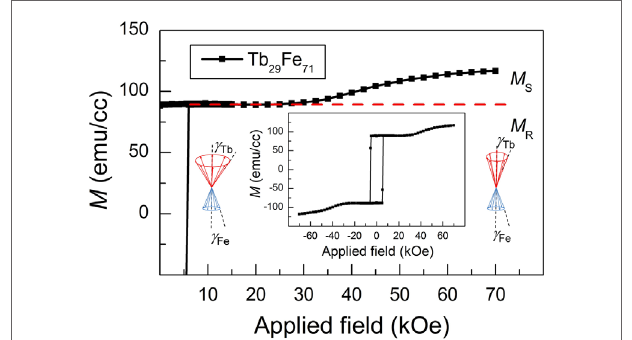
FigUre 2 | saturation branch of the hysteresis loop measured at room temperature by sQUiD-VsM magnetometry for a 14-nm-thick Tb 29 Fe 71 film in out-of-plane geometry . Marked is the constant part of the hysteresis branch M R before M increases again due to the compression of the Tb fanning cone angle γ Tb and reaches the saturation magnetization M S . Inset shows the full hysteresis